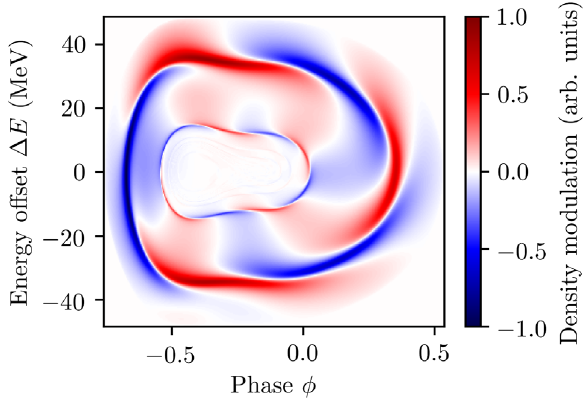
FIG. 14. Real (solid lines) and imaginary (dashed lines) parts of van Kampen modes as functions of bunch intensity for E ¼ 0 . 12 , when rf nonlinearity and PWD are max